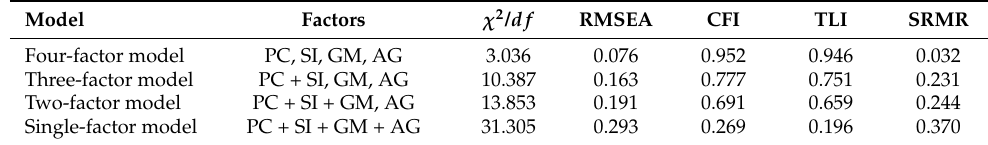
Table 2. Confirmatory factor analysis ( N =